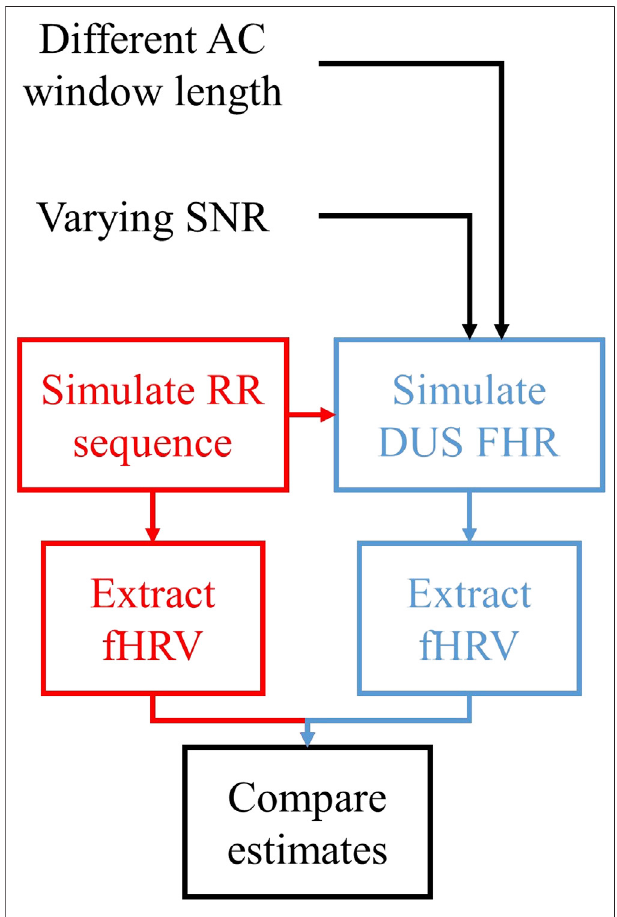
FIGURE3| OutlineoftheassessmentofthefHRVestimationdifferences between FHR RRI and FHR DUS . We simulate a set of RR intervals, and estimate the fHRV features. We also use these sequences to simulate FHR DUS varying AC window length and SNR. Finally, we estimate fHRV from these signals and compare the differences in estimates from FHR RRI and FHR DUS